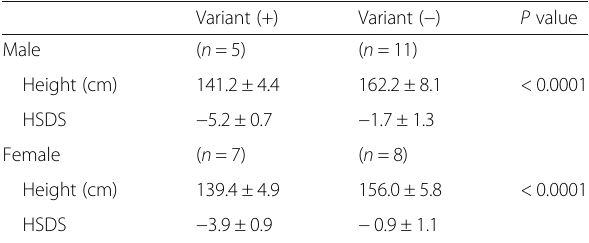
Table 2 Adult heights of family members with and without ACAN